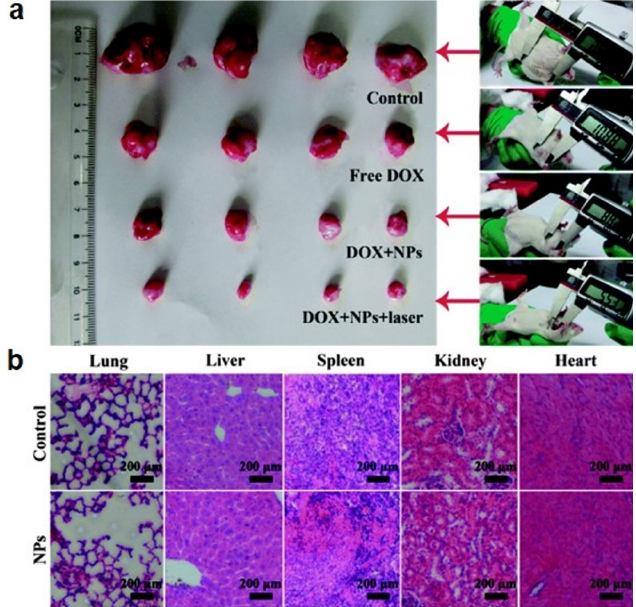
Figure 9. ( a ) Representative photographs of excised tumors from each group on the 11th day after treatment ( left ) and images of Kunming mice with tumors ( right ). ( b ) Hematoxylin-and-eosin-stained histological sections of major organs (heart, liver, spleen, lung, and kidneys) from mice treated with the control (saline) and H–AuNFs. Reprinted with permission from Ref. [20]. Copyright 2015, The Royal Society of Chemistry.